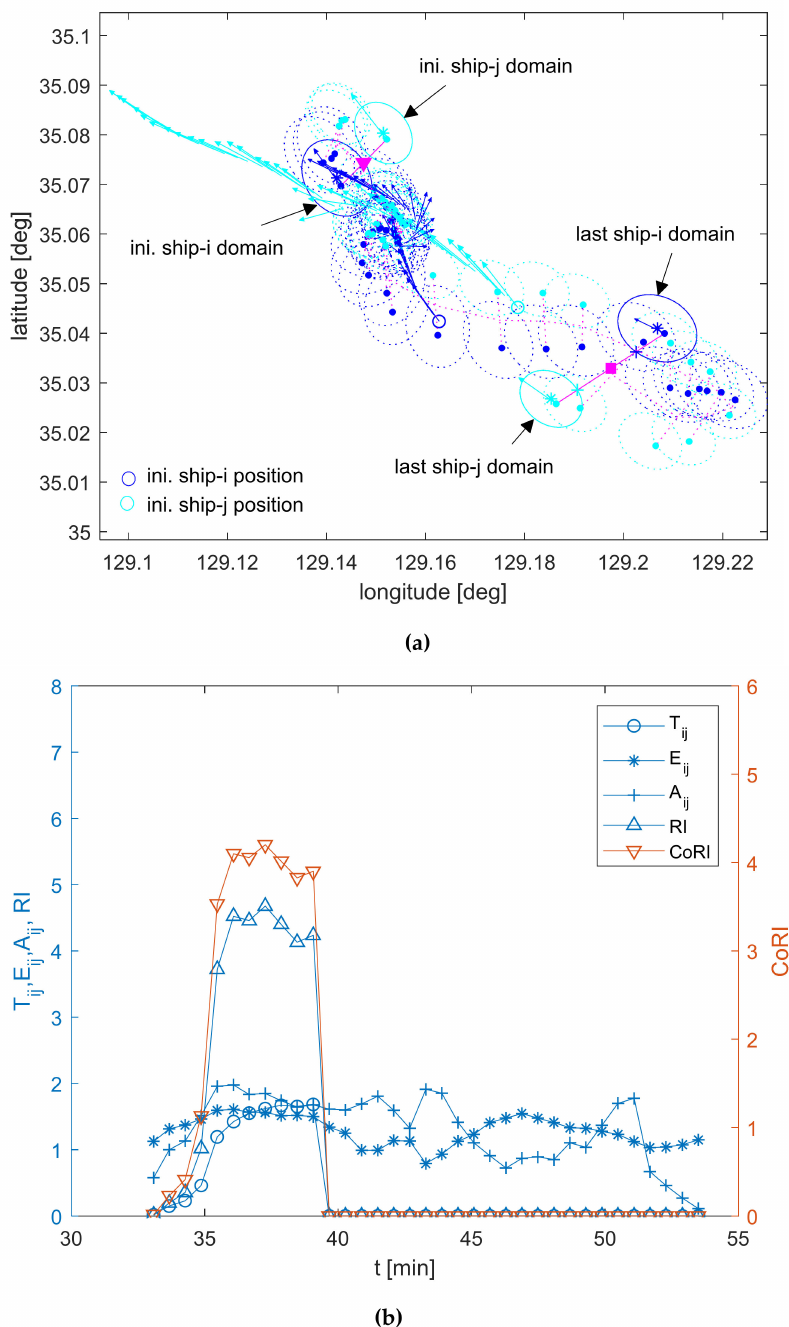
Figure 4. ( a ) Ship tracks with VTSO ship domain at CPA position ( · : CPA position, ← : 3-min vector); ( b ) CoRI results with T, E, and A indices of scenario no.1 ( ship-i : ship-1, ship-j :